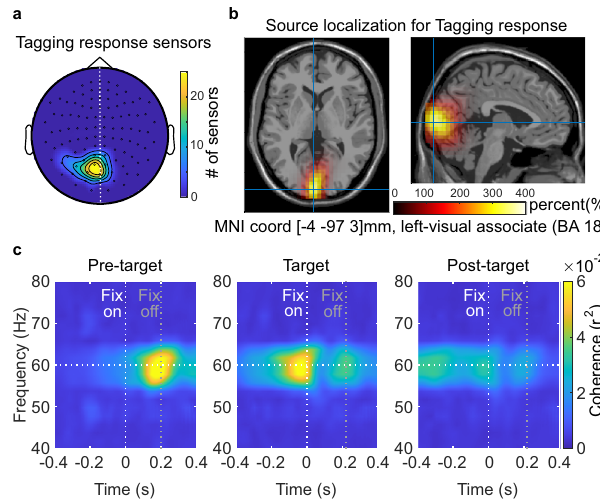
Fig. 3 Neural responses of the rapid invisible frequency tagging. a Topography for sensors from all participants that showed stronger tagging responses during the pre-target period ( fl icker) compared with the baseline period (no- fl icker, n = 26). b These tagging responses were localized in the left visual cortex. c The time-course of neural tagging responses during the pre-target (left panel), target (middle panel), and post-target fi xation periods (right panel). Vertical white and gray lines indicate fi xations onsets and average